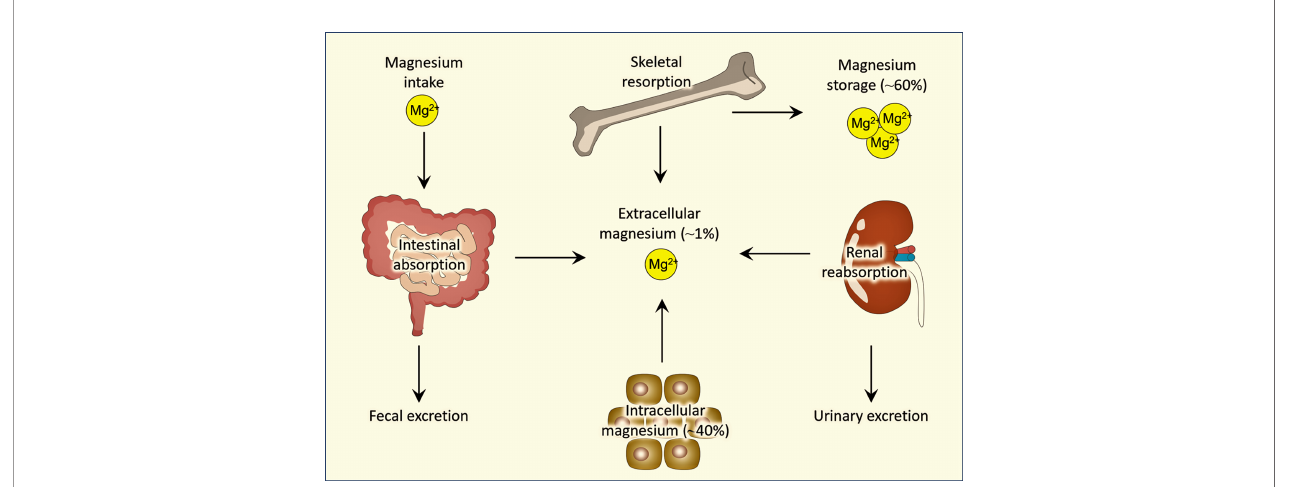
FIGURE 1 | Simpli fi ed diagram showing regulation of magnesium